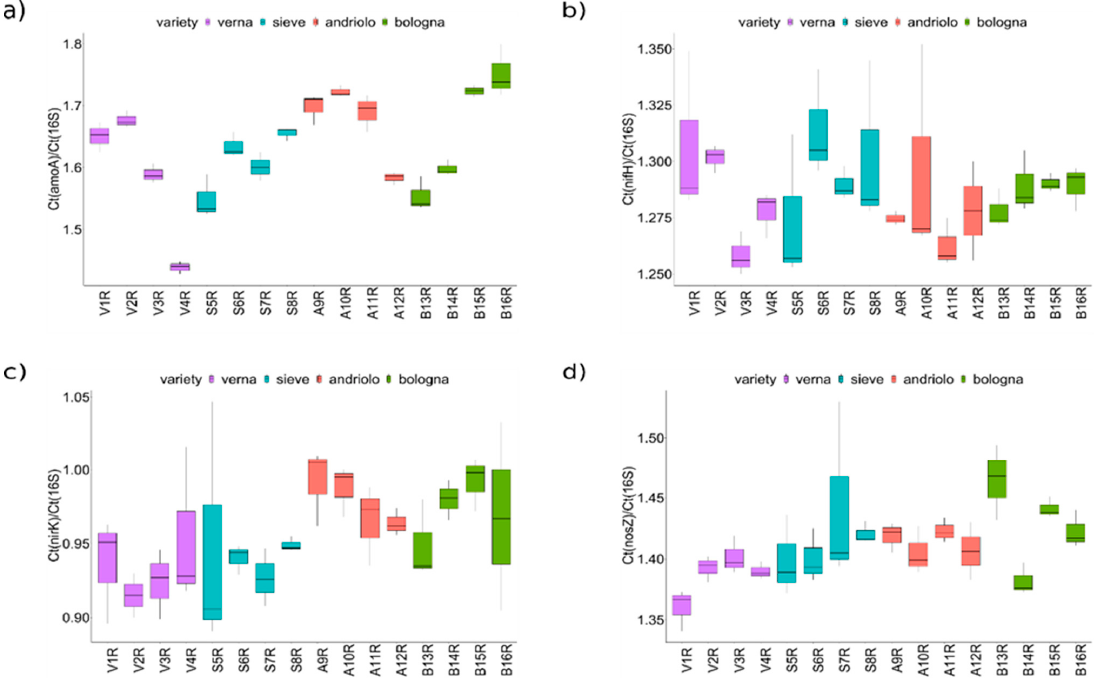
Figure 6. Clustering of pathways abundance. In panel ( a ), Nonmetric Multidimensional Scaling anal- ysis (nMDS) was performed considering the predicted functional abundances of all identified path- ways. In panel ( b ), a heatmap considering the top three pathways that differentiated each contrast between varieties returned by SIMPER test is represented. Codes of represented pathways